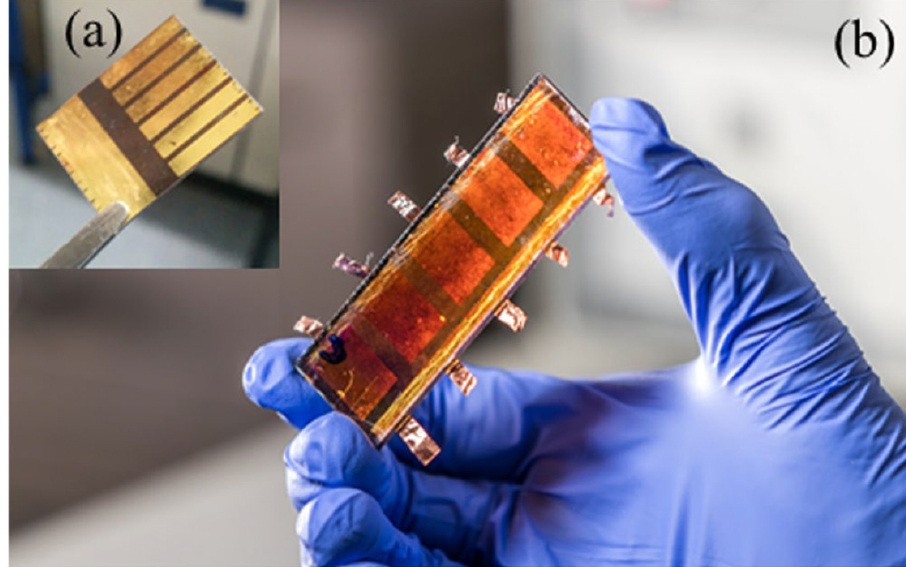
Figure 12. Comparison of ( a ) small- and ( b ) large-area PSC fabricated via spray coating. Reprinted from ref. [36].